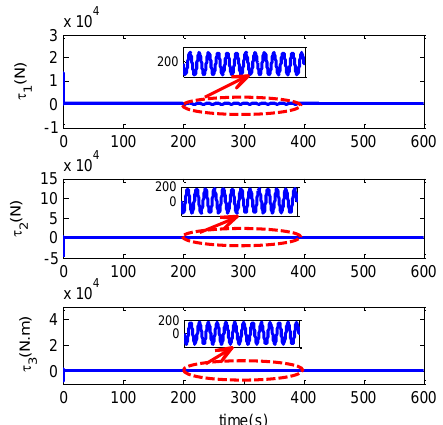
Figure 12. Control efforts of finite-time tracking control system.